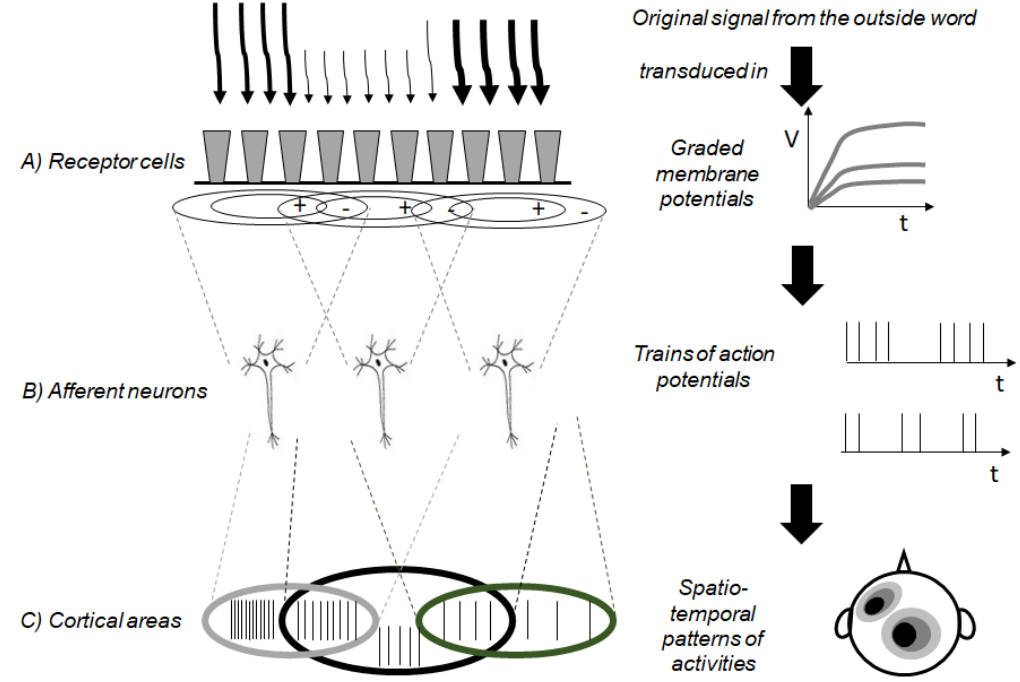
Figure 6. Scheme of the action of a sensory subsystem made of three principal elements described as three collections of fuzzy sets. First, the sensory cellular Fuzzy sets ( A ) that encode the information of a signal as graded potentials. Second, the afferent neurons ( B ) whose receptive fields are fuzzy sets: they encode the information as firing rates of the action potential trains. Third, the cortical areas ( C ) that are partitioned in different dynamic regimes giving rise to an infrastructure of fuzzy sets encoding distinct syntactic and semantic attributes of the original signals.